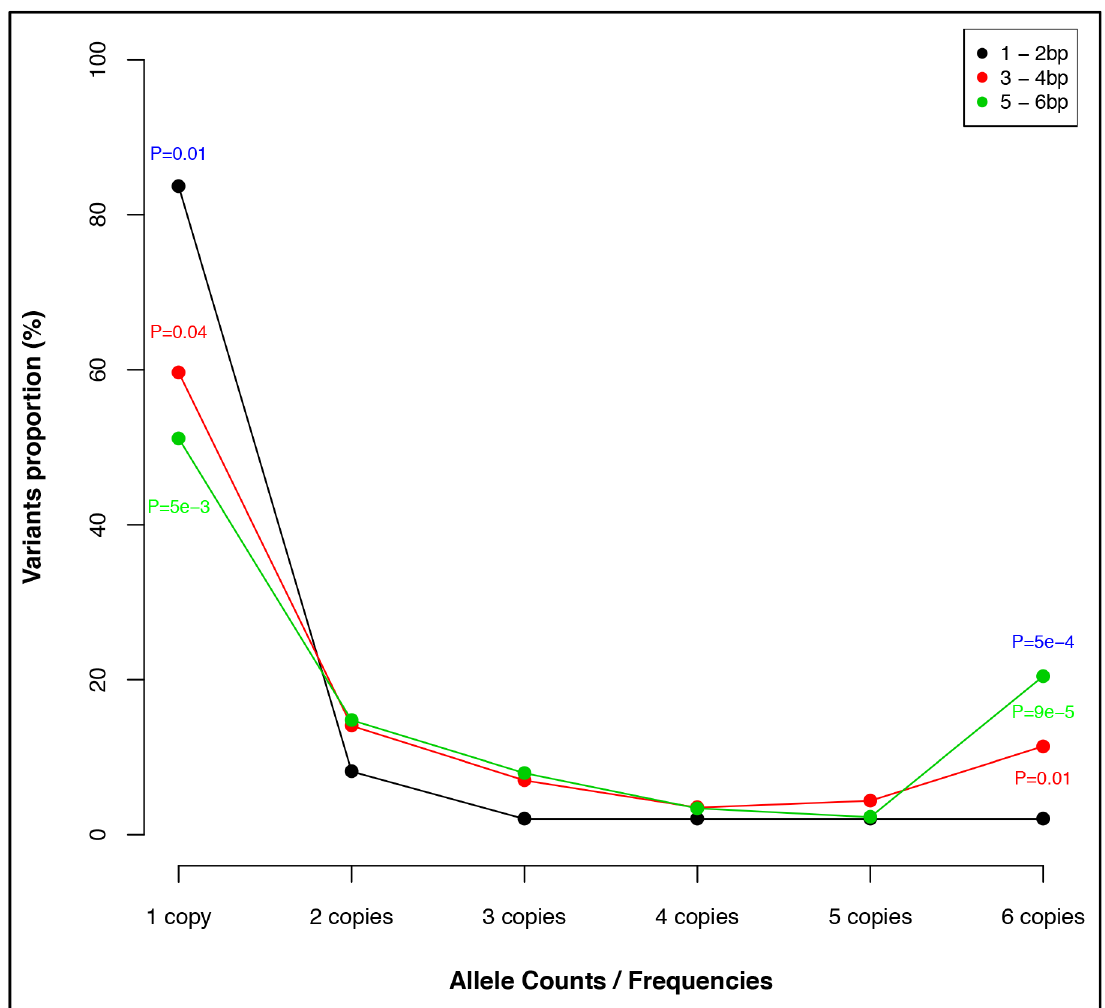
Fig 4. Titin population splice site/region allele frequency spectrum. TTN population non-essential splice-site variants ( > 2bp) have significantly lower proportion of private variants and higher proportion of low-frequency variants compared to essential splice-site variants ( P = 0.01; P = 5.1 × 10 − 4 , respectively). The P-values are shown for comparison between essential splice-site (1-2bp) and non-essential splice-site variants: 3 – 4bp (red), 5 – 6bp (green), and (blue) for combined